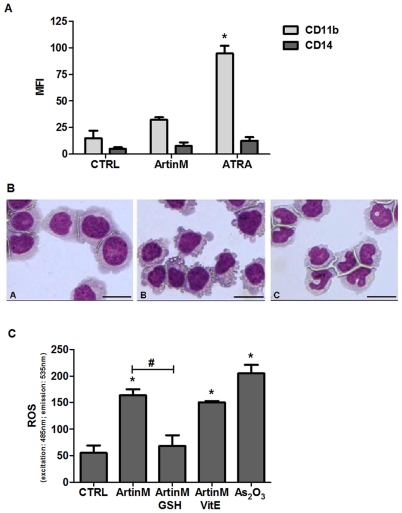
ArtinM does not induce NB4 differentiation but promotes ROS generation.NB4 cells were cultured for 48 h with ArtinM (10 µg/mL) or medium (CTRL), and then analyzed for 3 parameters. ATRA (1 µg/mL) or As2O3 (1 µM) were used as positive controls. A) Expression of CD11b and CD14 was evaluated by flow cytometry and expressed as mean fluorescence intensity (MFI). B) Morphology of NB4 cells was evaluated by optical microscopy of HEMA-stained cytospin preparations. Panel A: NB4 cells; Panel B: ArtinM-treated NB4 cells; Panel C: ATRA-treated NB4 cells. Bar = 10 µm. C) ROS production was evaluated by measuring the oxidative conversion of DCFH-DA to DCF in a fluorospectro-photometer. The effect of reduced glutathione (GSH) or α-tocopherol acetate (VitE) addition to ArtinM-stimulated cultures was also assayed. The results are expressed as optical density (OD) at excitation and emission wavelengths of 485 and 535 nm, respectively. The result shown are representative of 3 independent experiments and are expressed as mean ± SD, * p<0.05 (Tukey's test); # p<0.05 (ArtinM×ArtinM GSH, Tukey's test).